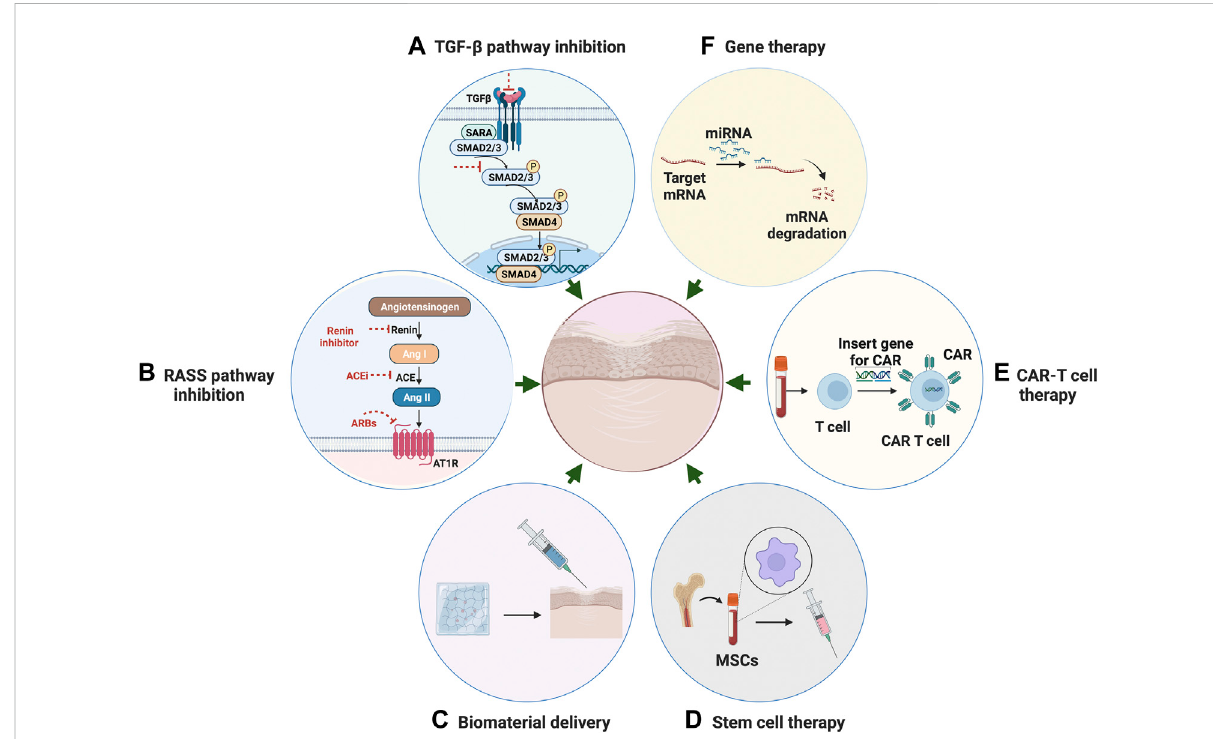
FIGURE 4 Potential Therapeutic strategies for fi brosis. (A) Anti- fi brotic therapeutic strategies through inhibition of TGF- β pathway. (B) Therapeutic strategies through inhibition of RAS system. (C) Targeted anti- fi brotic therapeutic approach through biomaterial-based delivery. (D) Stem cell therapy with mesenchymal stromal cells for the treatment of fi brotic disease. (E) CAR T-cell therapy using engineered T cells for the treatment of fi brotic disease. (F) Gene therapy through mediating miRNA as a novel approach for anti- fi brosis